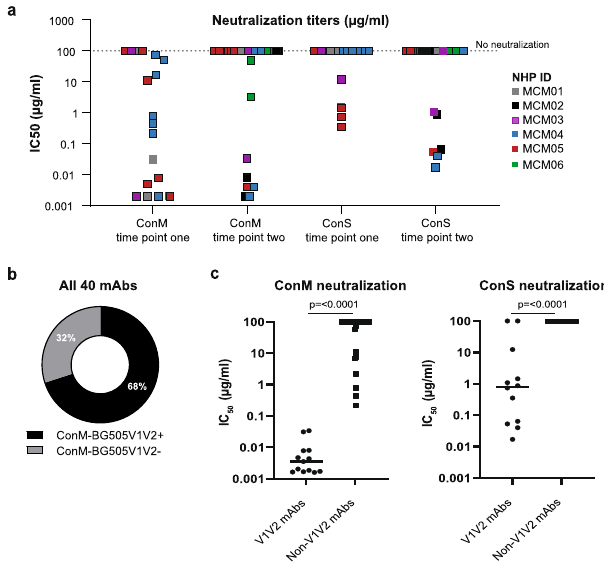
Fig. 3 Neutralization speci fi cities of the isolated mAbs. a Neutralization ability of all isolated mAbs for ConM and ConS virus, per time point. The y-axis shows the mean IC 50 values (µg/ml) for each of the mAbs, which are depicted in different colors for each animal. b mAbs were differentiated as either V1V2 targeting mAbs (32%) or non-V1V2 targeting mAbs (68%), based on their ability to bind ConM BG505 V1V2 protein in ELISA. c Ability of V1V2 targeting and non-V1V2 targeting mAbs to neutralize ConM and ConS virus. The y -axes show mean IC 50 values (µg/ml) for each of the mAbs. V1V2 targeting NAbs were signi fi cantly more potent in neutralizing ConM virus ( p ≤ 0.0001) and ConS virus ( p ≤ 0.0001). Two-tailed Mann – Whitney U tests were used to determine statistical